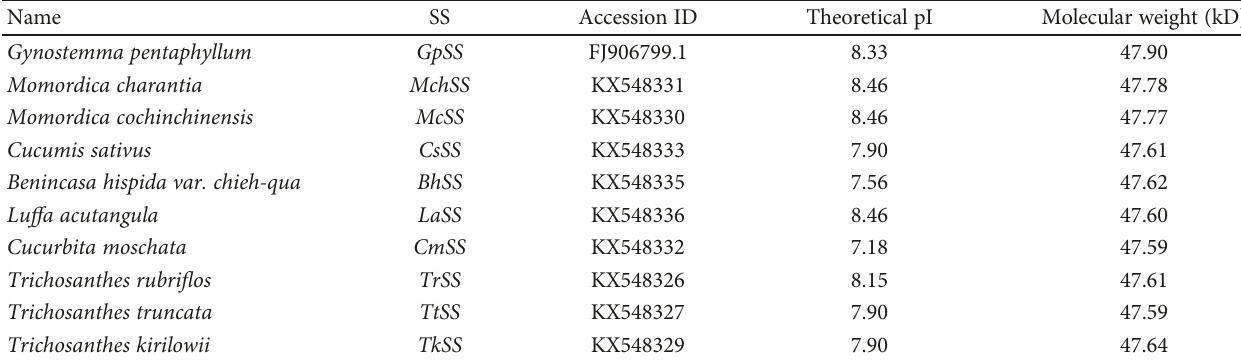
Table 1: Physical and chemical property analysis in SQS genes in